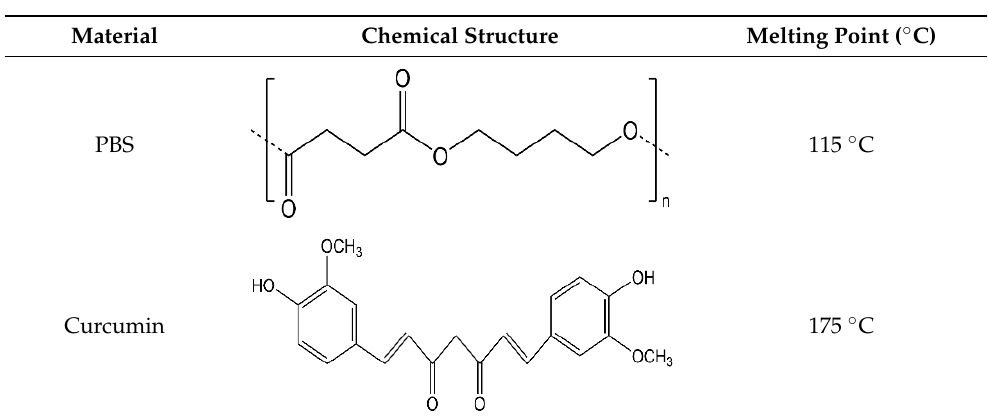
Table 1. Chemical structures and melting points of polybutylene succinate (PBS) and curcumin.